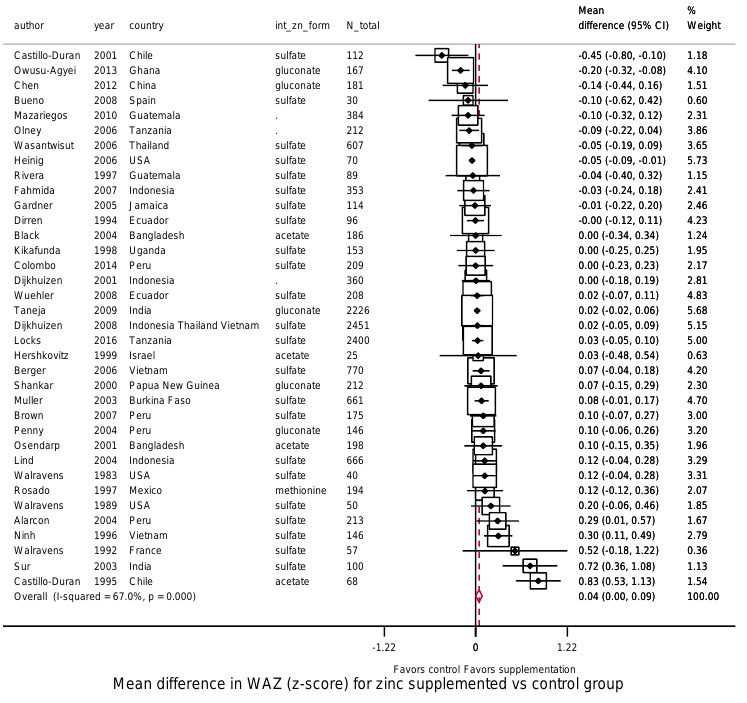
Figure 4. Effect of zinc supplementation among children aged < 5 y old on WAZ in randomized F igure 4: Effect of zinc supplementation among children aged<5 y old on WAZ in randomized controlled controlled trials.